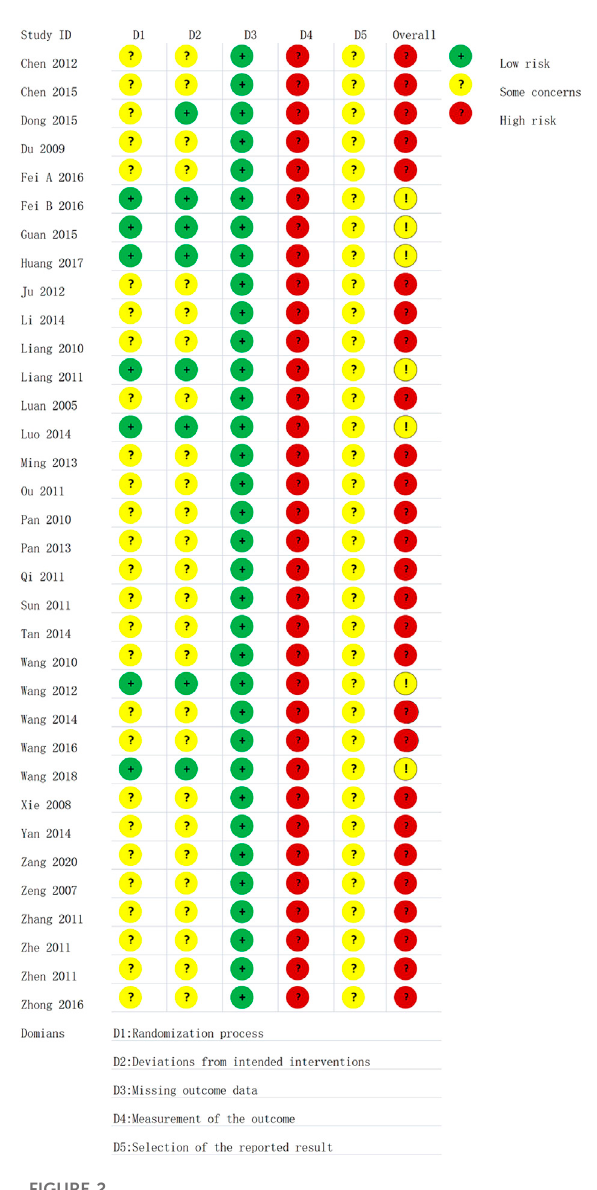
FIGURE 2 Risk of bias in each trial according to the Cochrane Ro B2